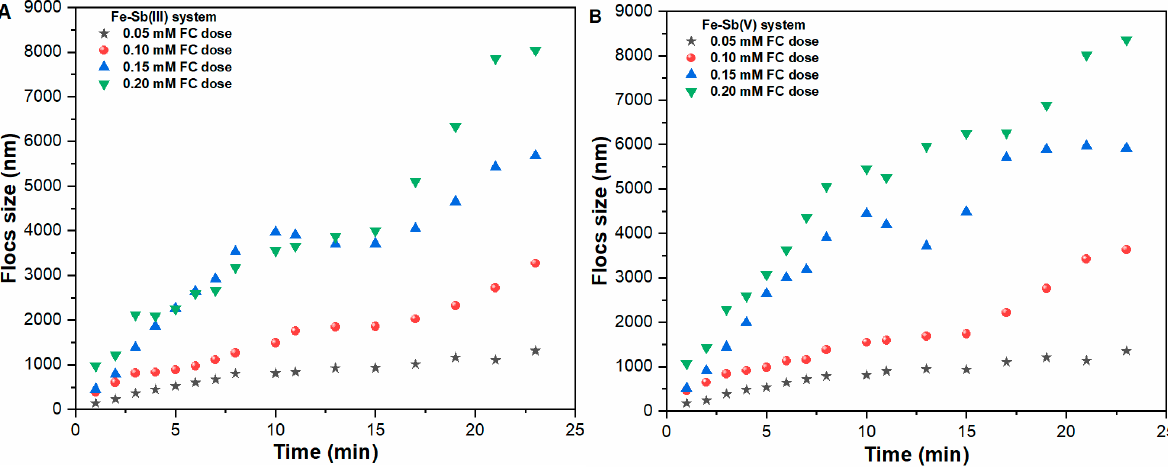
Figure 3. Aggregation of Fe precipitates in ( A ) Sb(III), ( B ) Sb(V) suspensions as a function of time under various applied FC dosages.